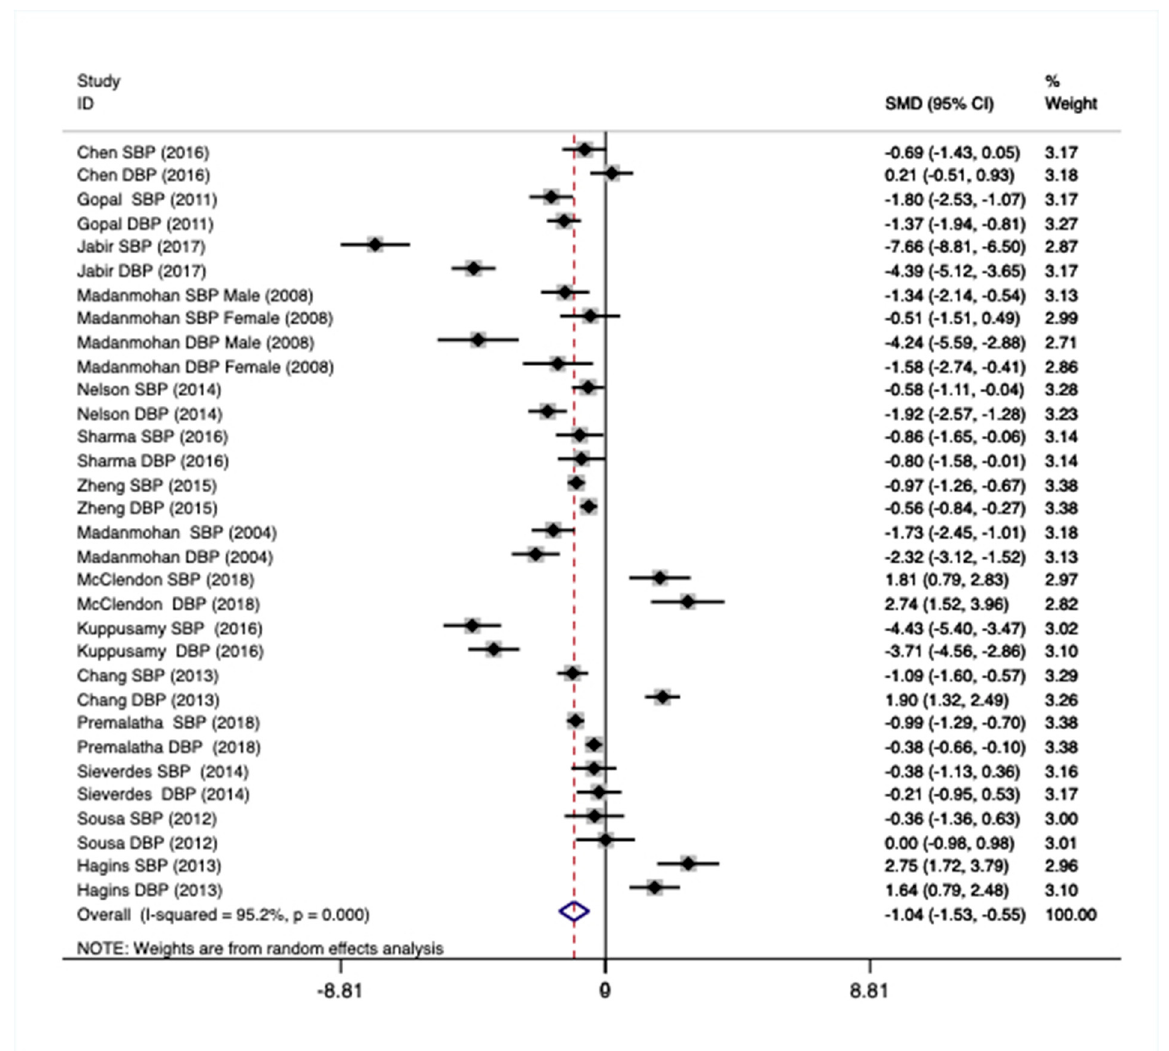
Figure 5. Forest plot showing the weighted pooled effect of Mind–Body physical activity interventions on blood pressure.